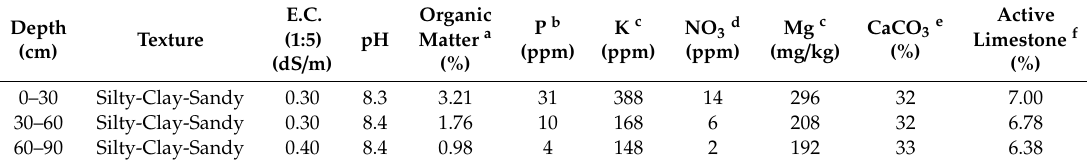
Table 2. Soil analysis